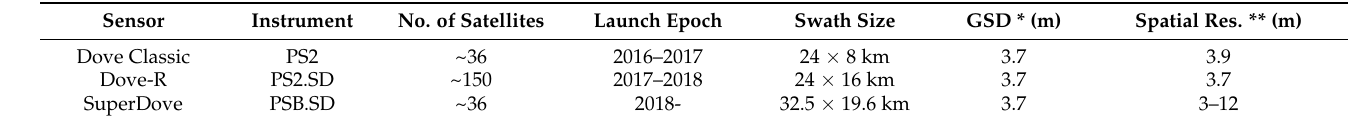
Table 1. PlanetScope sensor